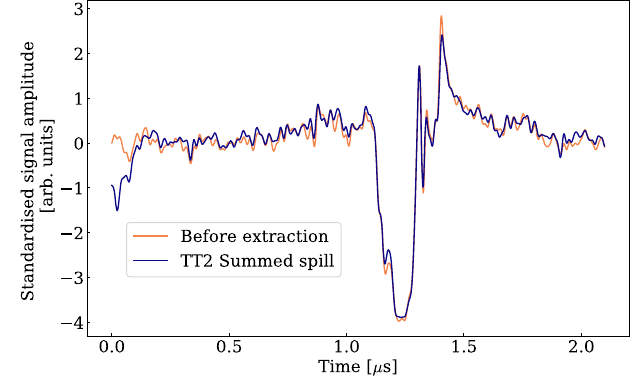
FIG. 8. The summed profiles from the fast beam current transformer in the TT2 transfer line compared with the WCM trace before